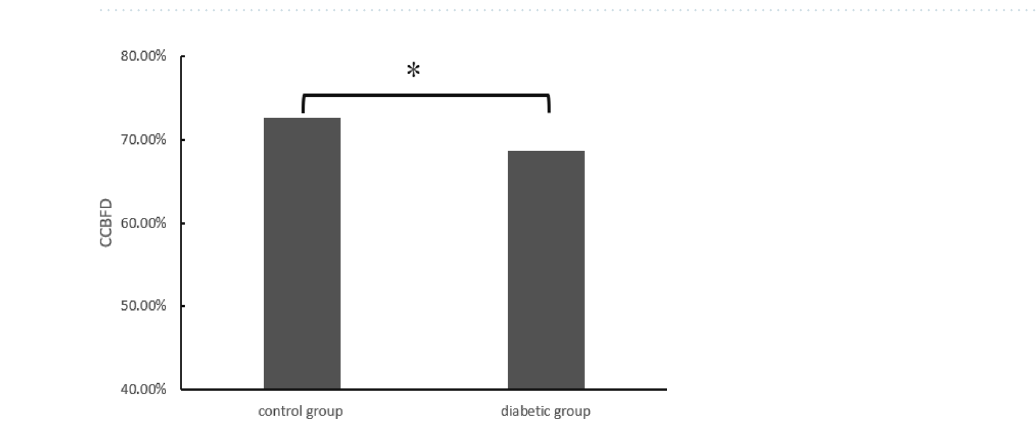
Figure 2. Choriocapillaris blood flow signal density by group after PSM. *Significantly related on the 0.05 level (both